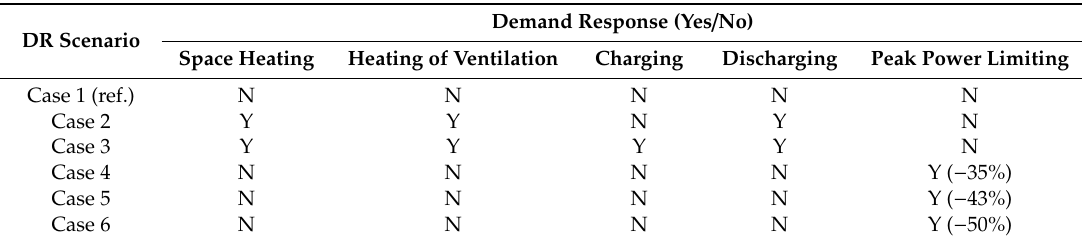
Table 1. The selected demand response (DR) scenarios adapted with permission from Martin [13]. Demand Response (Yes / DR Scenario